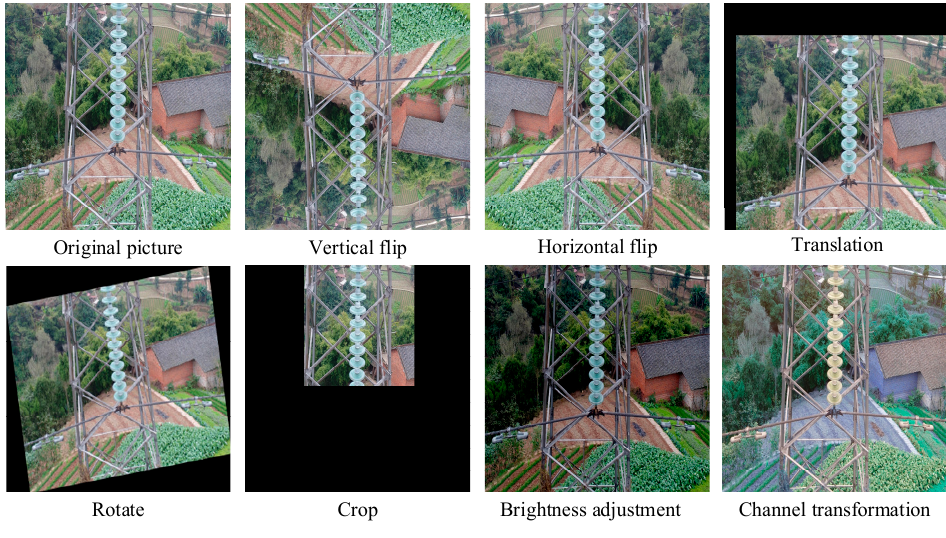
Figure 11. Data enhancement methods. Table 1. Parameters of hardware and Software equipment.